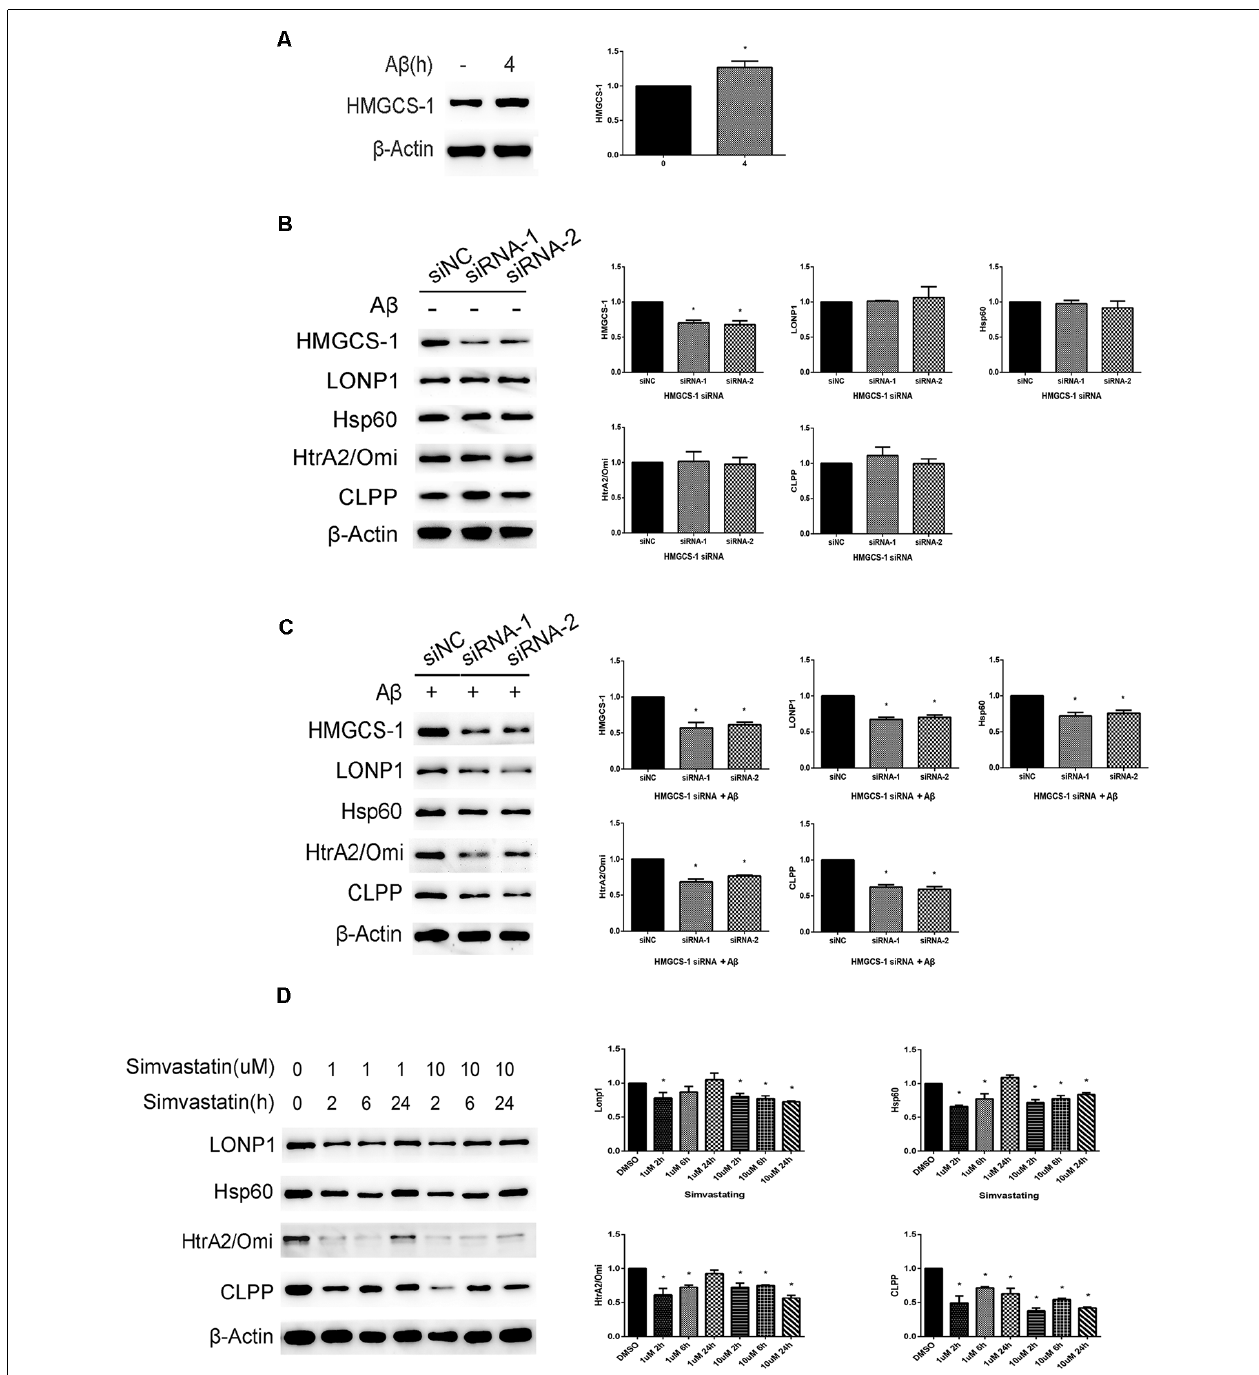
FIGURE 2 | Inhibition of the mevalonate pathway by HMGCS-1 siRNAs or simvastatin reduces the UPRmt reaction induced by A β 25–35 in SHSY5Y cells. (A) Western blot analysis of HMGCS-1 protein level in SHSY5Y cells treated with 20 µ M A β 25–35 for 4 h, quantification and β -Actin served as the internal control. The data are mean ± SEM ( n = 3, ∗ p < 0.05 vs. control group). (B) Western blot analysis of HMGCS-1 and UPRmt related proteins level in SHSY5Y cells transfected with scramble or HMGCS-1 siRNAs for 48 h, quantification and β -Actin served as the internal control. The data are mean ± SEM ( n = 3, ∗ p < 0.05 vs. siNC group). (C) Western blot analysis of HMGCS-1 and UPRmt related proteins level in SHSY5Y cells transfected with scramble or HMGCS-1 siRNAs for 48 h and 20 µ M A